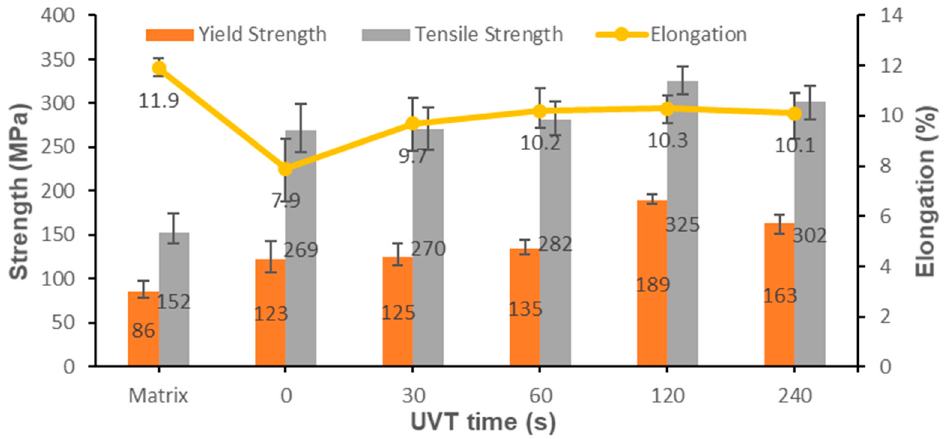
/ TiB2 composites and